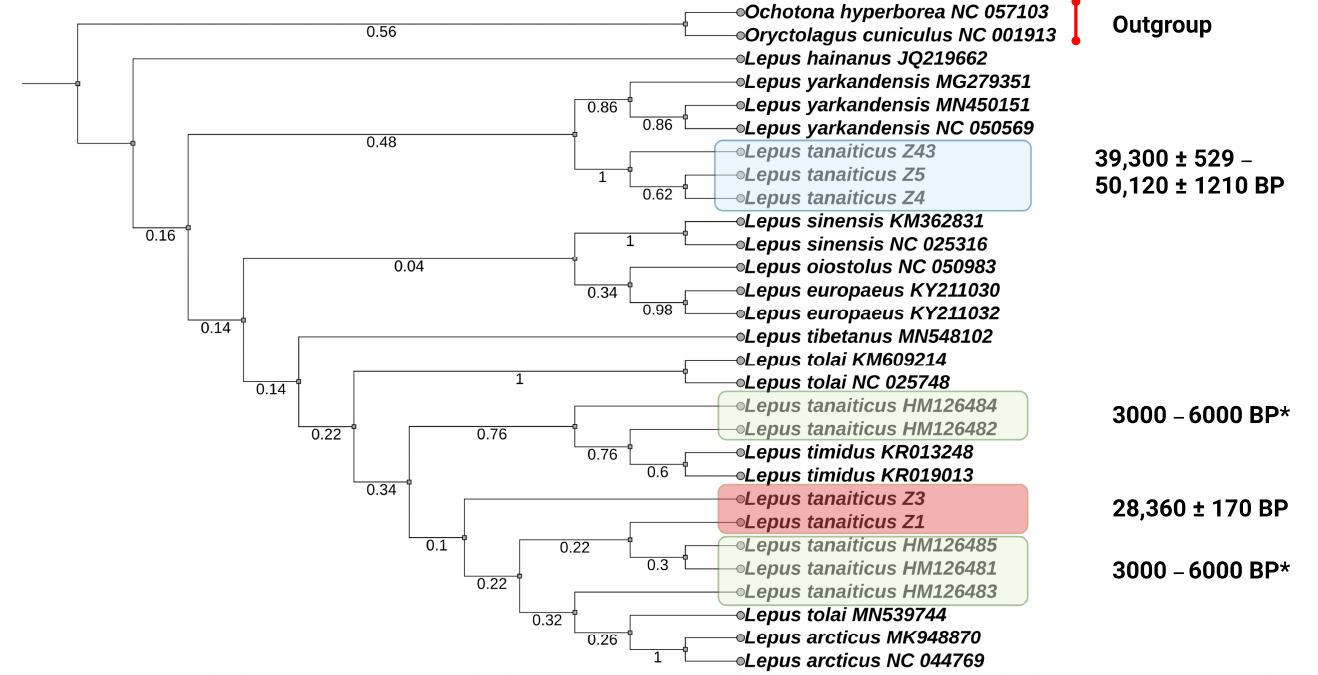
Figure 4. Parsimony phylogenetic tree of the Lepus species, including the extinct Don-hare based on nucleotide variability of a 338 bp D-Loop fragment. “Young” Yakutian specimens of L. tanaiticus from this study are marked by a red box and “old” Yakutian specimens of L. tanaiticus from this study are marked by a blue box. Green boxes represent previously published L. tanaiticus specimens from the valley stream Pymva Shor (Polar Urals, Russia) [23]. *—These individuals are dated as Holocene specimens according Prof. Stefan Prost.